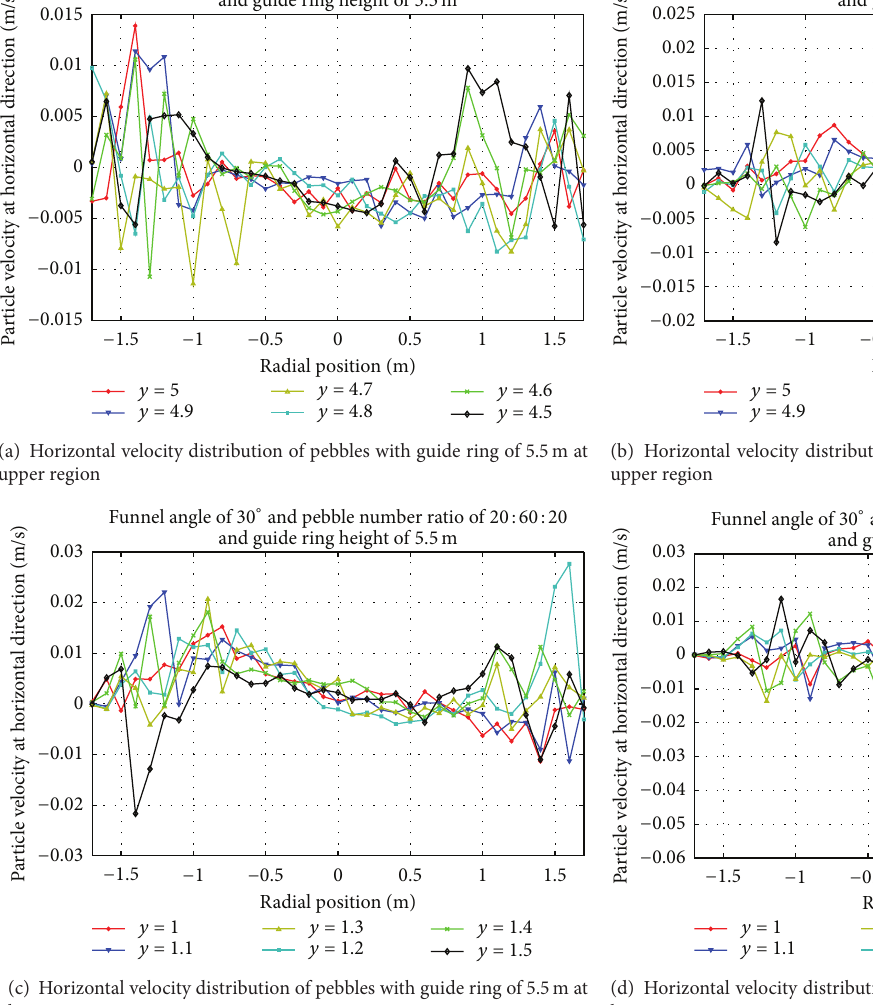
mFunnel angle of 30 ∘ and pebble number ratio of 20 : 60 : 20 and guide ring height of 6